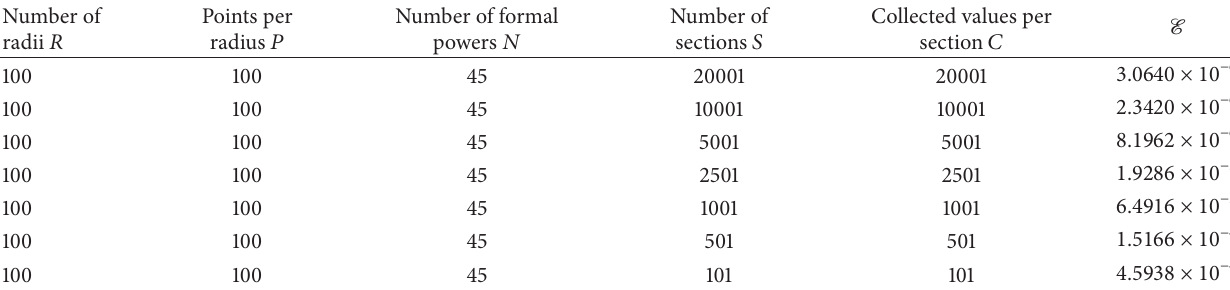
Table 12: Relation between the error E and the number of formal powers 𝑁 , when 𝜎 = 𝑥 + 𝑦 + 10 . Number of radii 𝑅